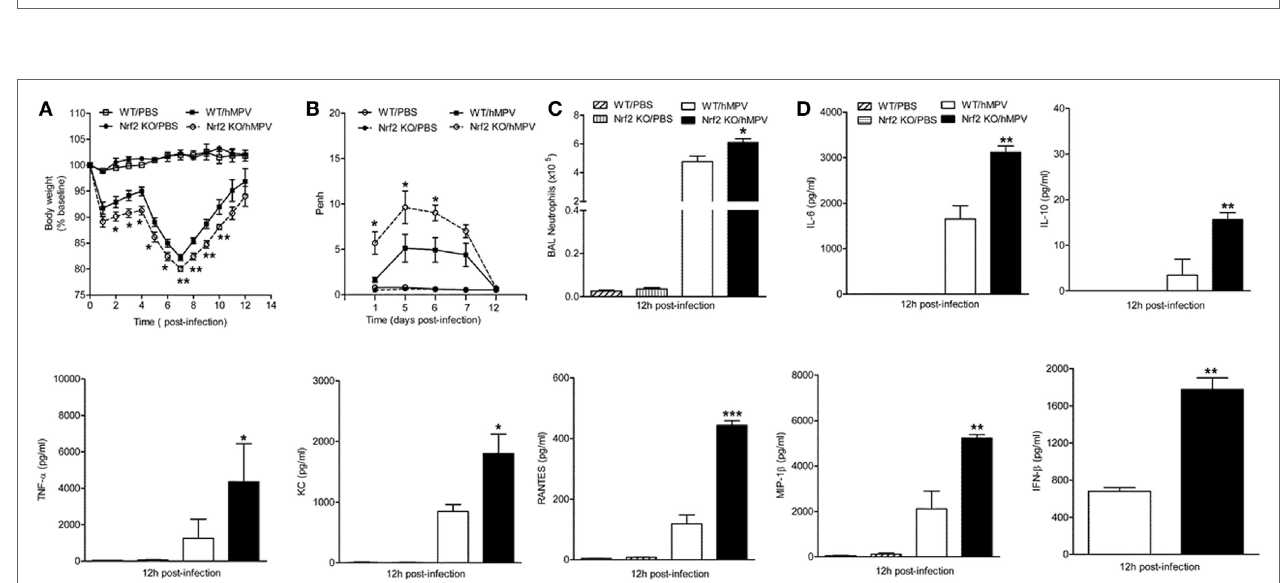
FigUre 7 | Decreased levels of antioxidant enzymes and hydrogen sulfide enzymes in NF-E2-related factor 2 (Nrf2)-deficient mice. Nrf2 KO and wild type (WT) mice were infected with respiratory syncytial virus (RSV) or PBS and harvested at day 1 post-infection to isolate total RNA from lungs. (a) Catalase (left panel) and Cu/Zn-superoxide dismutase-1 (right panel) gene expression were quantified by quantitative real-time PCR (and expressed as fold change). The bar graph represents mean ± SEM ( n = 3 mice/group). * p < 0.05 Nrf2 KO/RSV vs. Nrf2 KO/PBS, ** p < 0.01 Nrf2 KO/PBS vs. WT/PBS, WT/RSV vs. WT/PBS, and Nrf2 KO/ RSV vs. WT/RSV, *** p < 0.001 Nrf2 KO/RSV vs. Nrf2 KO/PBS. (B) CSE, CBS, and 3-mercaptopyruvate sulfurtransferase mRNA levels were measured by quantitative real-time PCR (expressed as fold change). The bar graph represents mean ± SEM ( n = 3 mice/group). * p < 0.05 Nrf2 KO/RSV vs. Nrf2 KO/PBS, and Nrf2 KO/RSV vs. WT/RSV, *** p < 0.001 Nrf2 KO/RSV vs. Nrf2 KO/PBS.